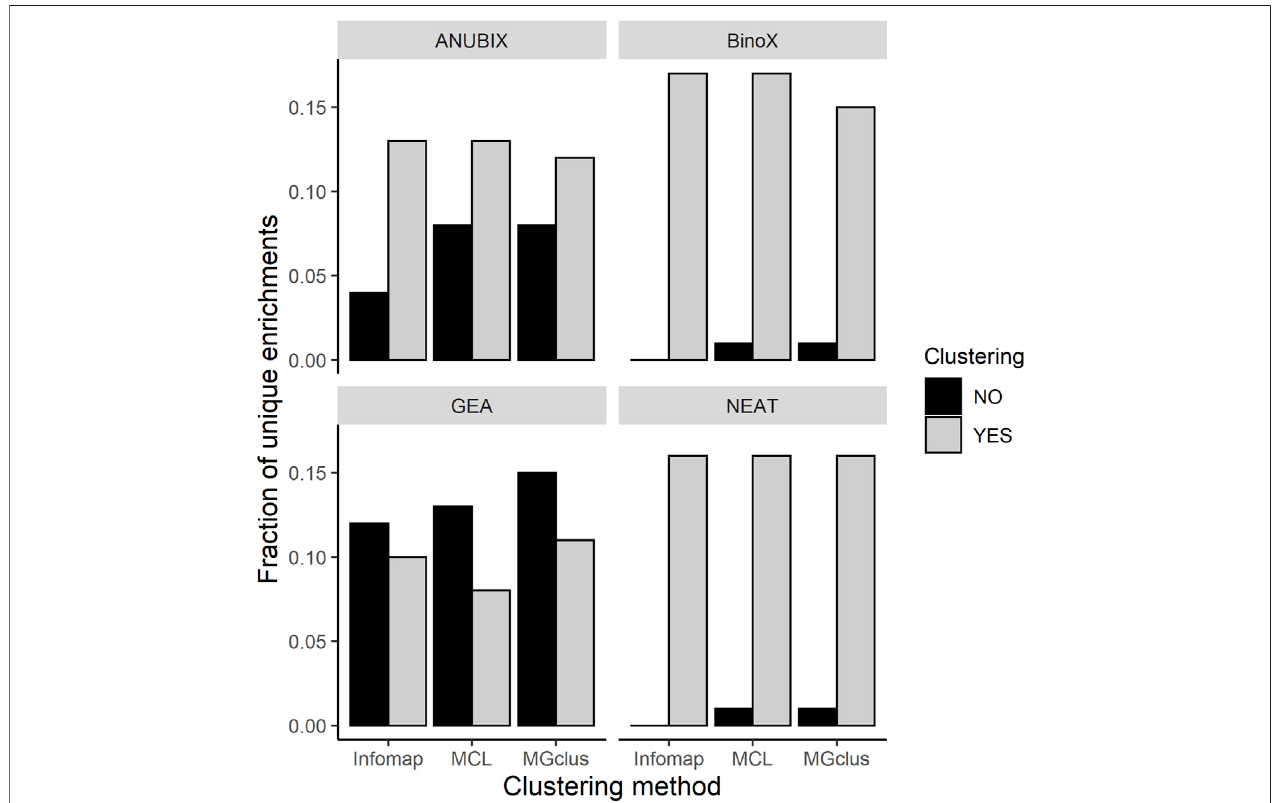
FIGURE 5 | Fractions of unique pathway enrichments found with pre-clustering relative to without pre-clustering, and vice versa, run at FDR = 0.05 for all the combinations of clustering methods and pathway enrichment